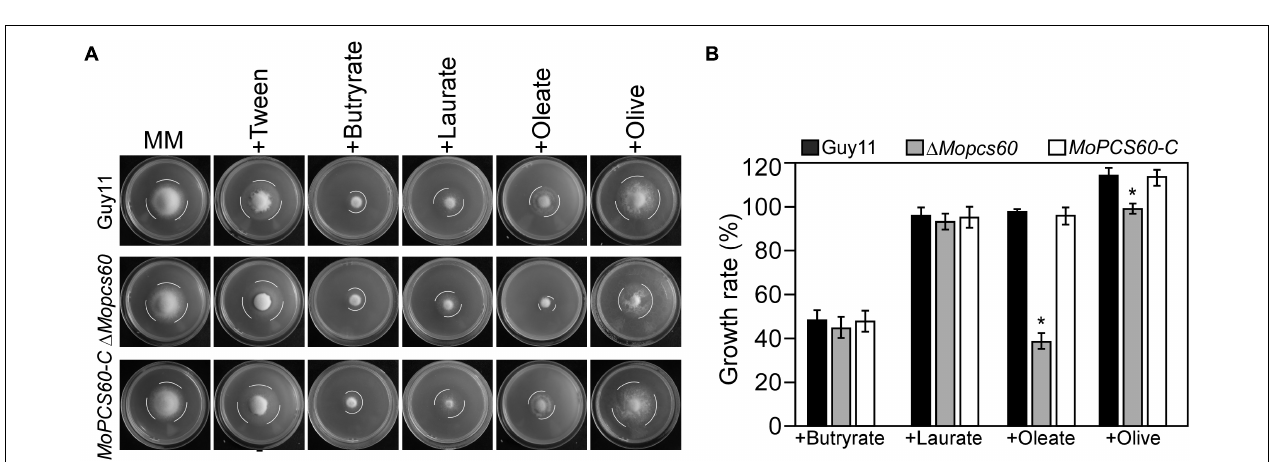
FIGURE 4 | The (cid:49) Mopcs60 mutant shows defect in utilization of long-chain fatty acids. (A) The wild-type strain Guy11, (cid:49) Mopcs60 mutant, and the complemented transformant MoPCS60-C were grown on minimal medium and MM with butyrate (1 mM), laurate (1 mM), olive (1% w/v), and oleate (1 mM) as the sole carbon sources and incubated at 28 ◦ C for 7 days. (B) Statistical analysis of the growth rate of the indicated strains on different media. Error bars are standard deviations from three biological repeats, and asterisk represents significant differences at * p <